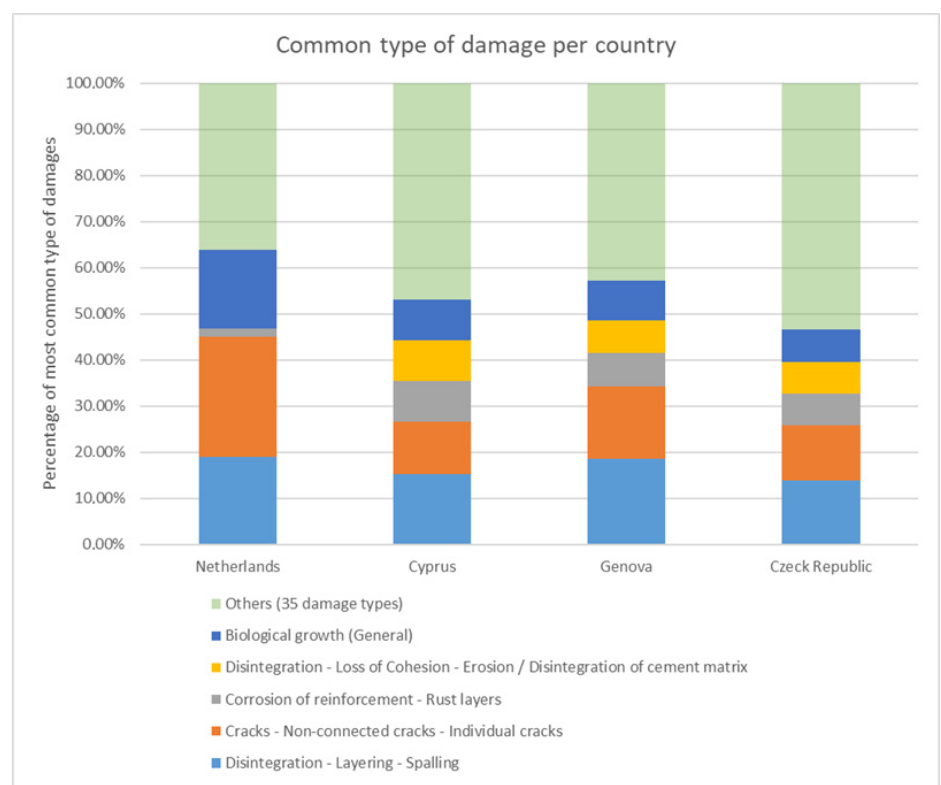
Figure 4. Damage types per country. Table 2. Types of damage found in the buildings investigated, percentage, and